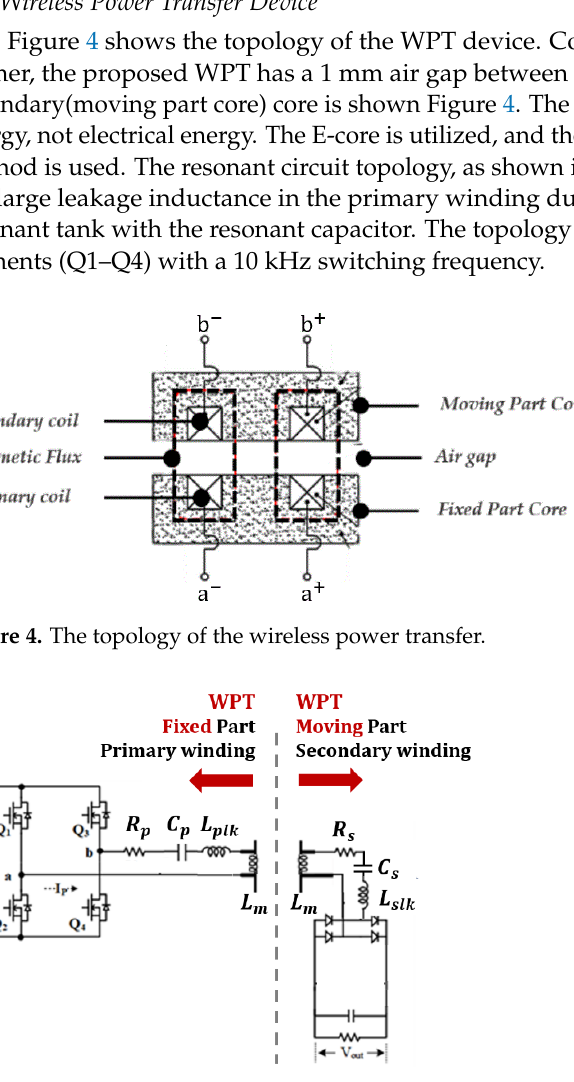
Figure 5. The topology of the wireless power transfer circuit diagram of the power supply.